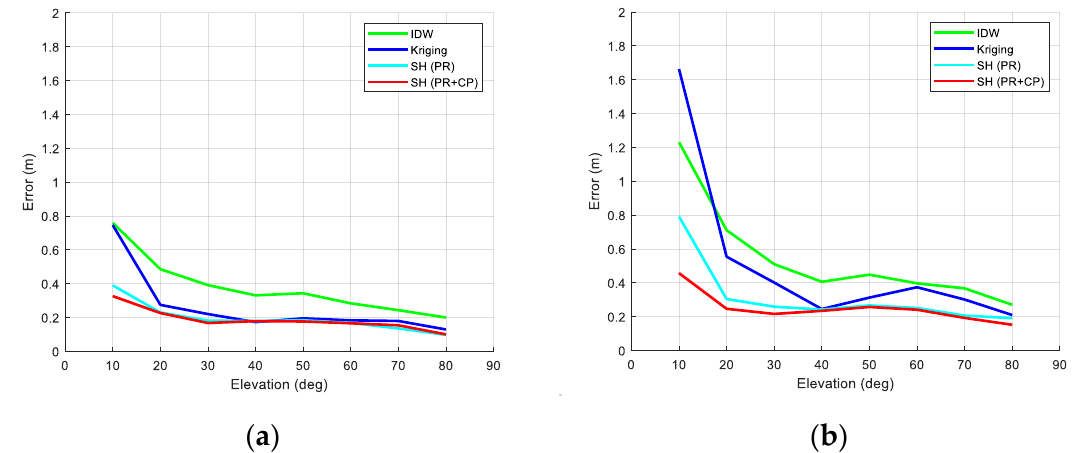
Figure 13. Residual error according to the elevation angle (real data, 1 September 2014): ( a ) Users 1 and 5; ( b ) Users 2 – 4.